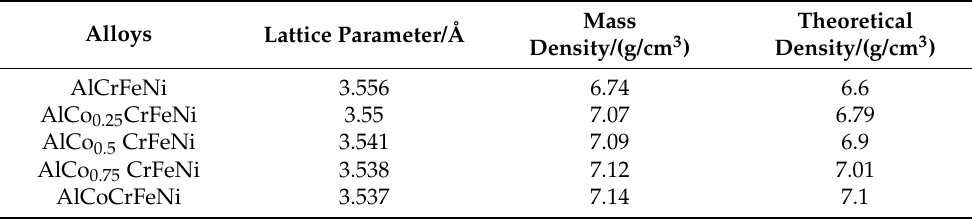
Table 3. Lattice constant and density of AlCo x CrFeNi (x = 0, 0.25, 0.5, 0.75, 1) HEAs. Alloys